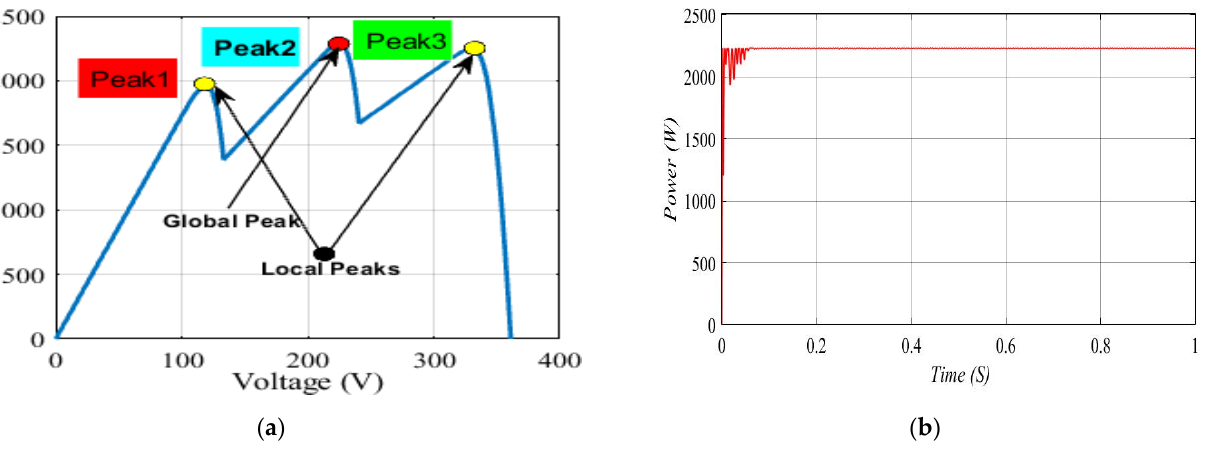
Figure 9. Details of actual power and proposed CSA-PID power under STC. ( a ) PV curve under STC (1000 W/m 2 and 25 °C). ( b ) The output power of proposed CSA-PID under STC.